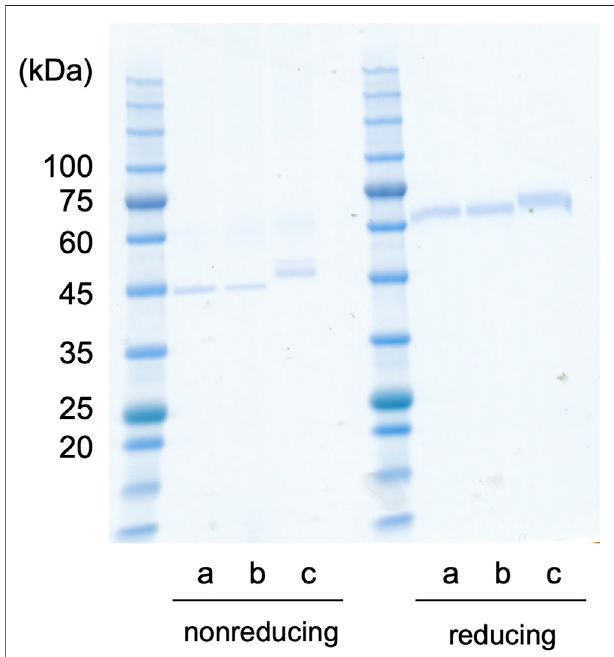
FIGURE4| CLucexpressioninsilkworm.CLuc SW recombinantproteins (200 ng for each lane) were analyzed by SDS-PAGE. The gel mobility was different under reducing or non-reducing conditions. The apparent molecular weight was higher under reducing conditions than under non-reducing ones, showing relative compact folding of the recombinant proteins under non-reducing condition probably due to disul fi de bonding. In both cases, the recombinant Wt CLuc SW band looks larger than the Dmt CLuc SW band. (a) Dmt CLuc SW . (b) N182D + N404D mutant CLuc SW . (c) Wt CLuc SW